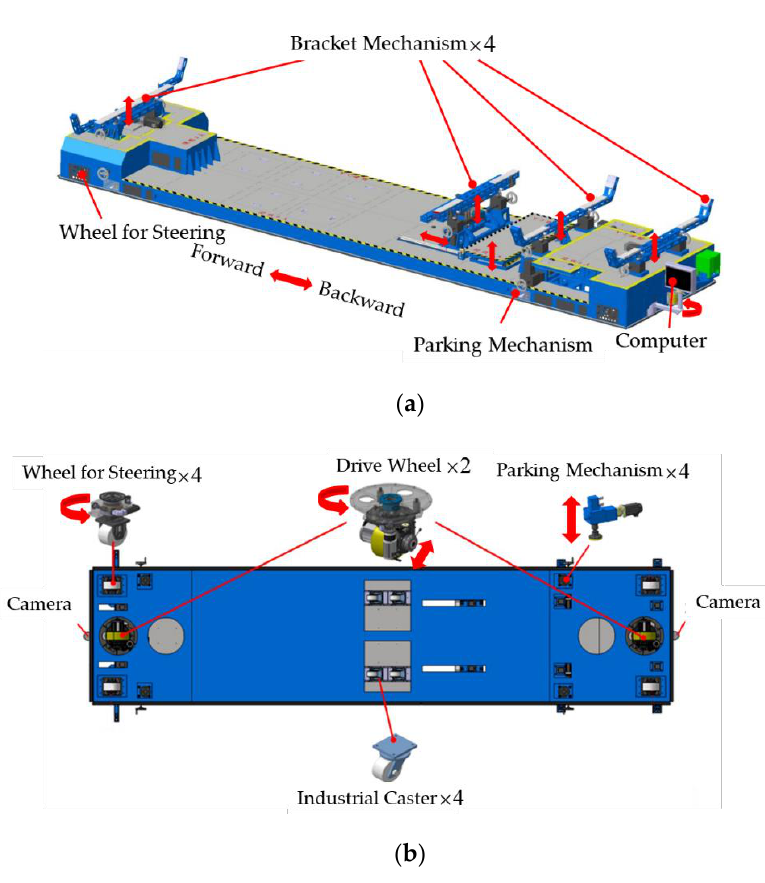
Figure 1. Mechanical structure of the transport platform: ( a ) 3D model; ( b ) bottom view. Table 1. Dimensions and specifications of the transport platform.